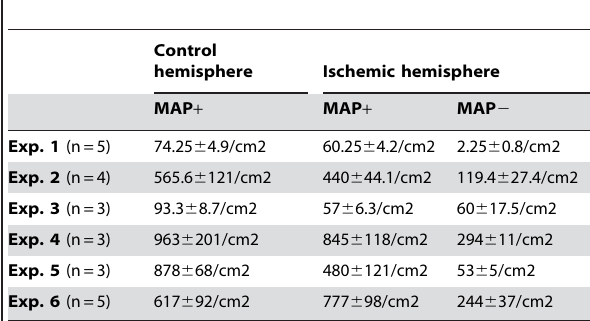
Table 1. Mean NCs density (cells/cm 2 ) in the MAP-2 positive zone contralateral (left column) and ipsilateral (middle column) to the ischemic side and in the MAP-2 negative zone of the ischemic hemisphere (right column) in 6 different experiments.